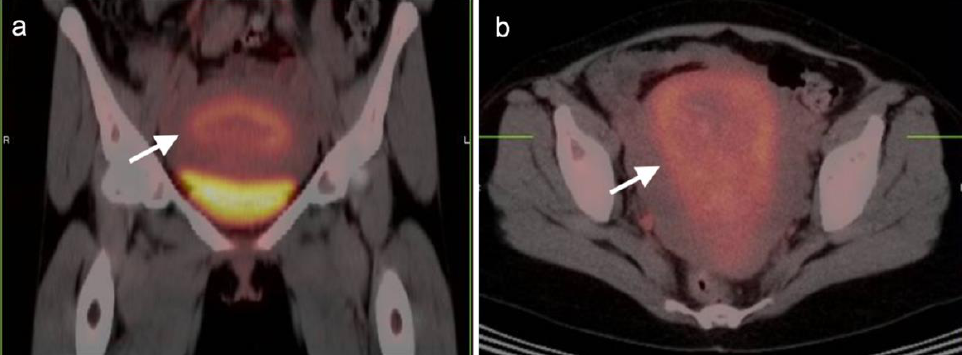
Figure 3. Post-partum uterus. ( a ) Coronal and ( b ) axial FDG-CT images of the pelvis show an enlarged uterus with a thickened rind of metabolically active endometrium (white arrow). Note that it is the endometrium, not the myometrium, that is hypermetabolic.